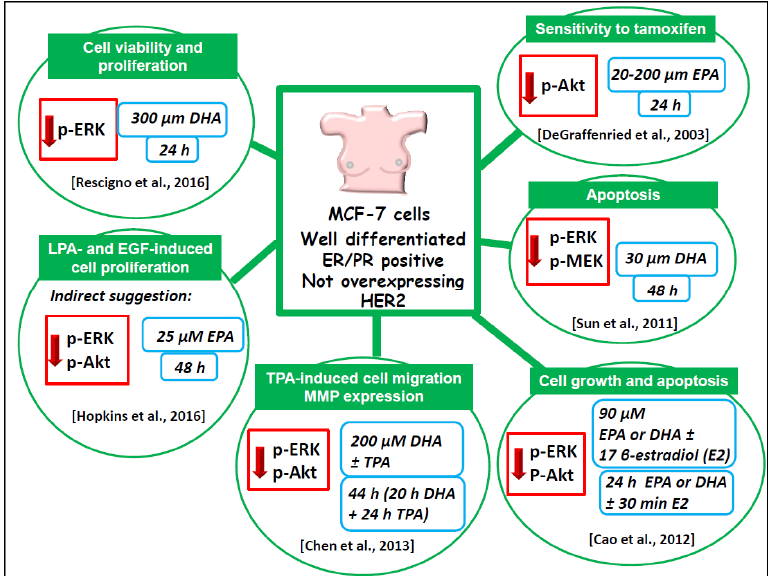
Figure 5. Outline of the main results of the in vitro reports investigating LCn ‐ 3 PUFA regulation of ERK and AKT and their upstream components in the ERK and phosphoinositide survival pathways in MCF7 breast cancer cells. The green labels show the main features, functions, or cellular processes that are related to cell growth and regulated in an antineoplastic sense by LCn ‐ 3 PUFA in these breast cancer cells. The red arrows indicate negative regulation by LCn ‐ 3 PUFA. The light blue boxes illustrate the LCn ‐ 3 PUFA concentrations used and the length of incubations with fatty acids.